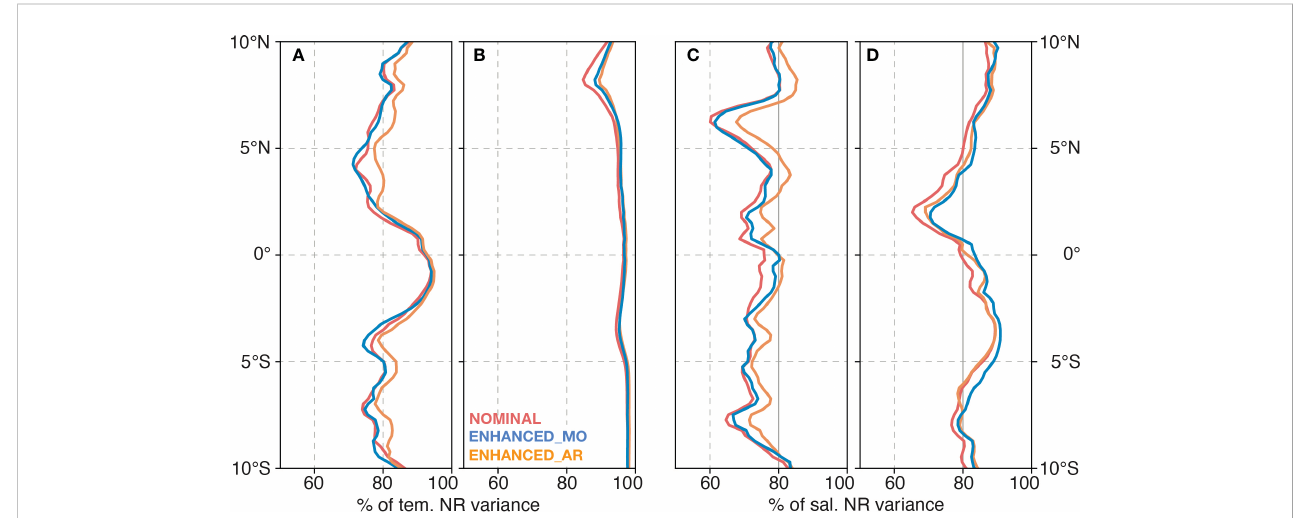
FIGURE 9 Percentage of Nature Run (NR) temperature (A, B) and salinity (C, D) represented variance at intermediate (A, C) and large (B, D) scales for NOMINAL (in red), ENHANCED_MO (blue), ENHANCED_AR (orange) experiments, zonally averaged in the tropical Paci fi c.